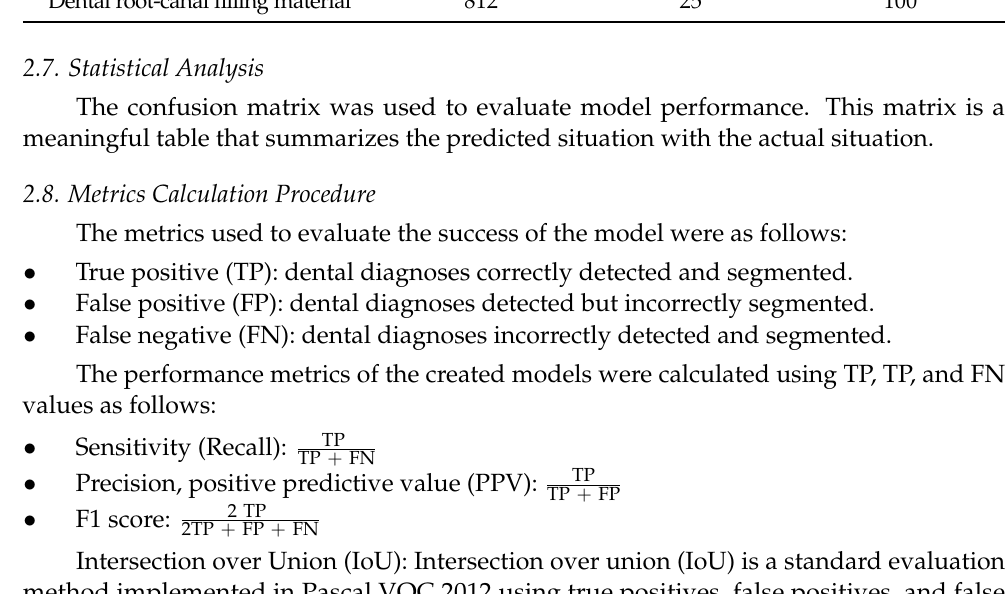
Table 1. Training, testing, and validation groups on bite-wing images for five different dental diag- noses.